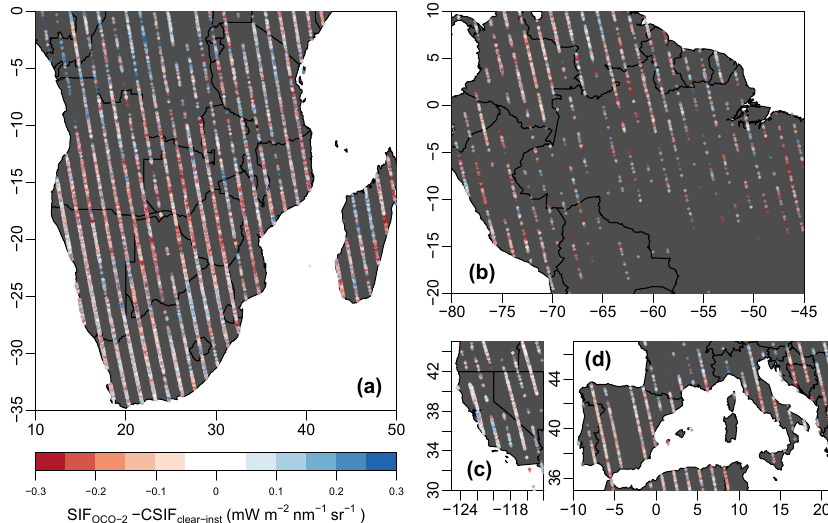
Figure 11. Difference between the OCO-2 SIF and CSIF clear-inst for four specific drought events during 2014–2017. (a) Southern Africa drought between October 2015 and February 2016. (b) Northeast Amazon drought between January and March 2016. (c) California drought between January and March 2015. (d) Southern Europe drought between July and August